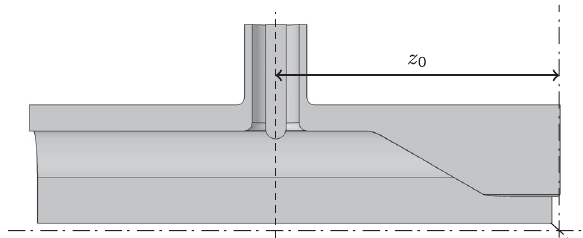
FIG. 10. Fundamental mode coupler close to the 30 deg taper.